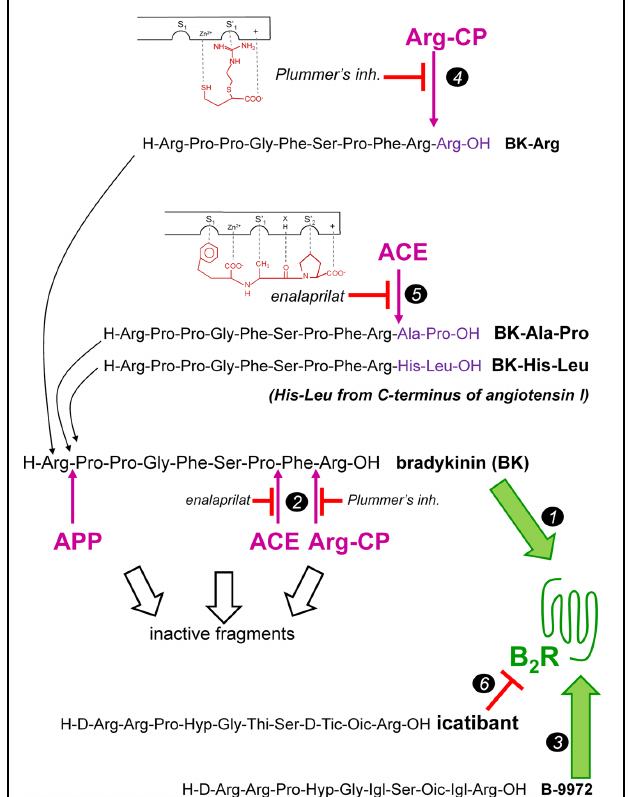
FIGURE 1 | Previously described BK-related peptides tested in vivo as B 2 R agonists in the present study. BK is a direct high affinity agonist (marker 1 ) that is intrinsically fragile, being degraded by several peptidases that terminate its signaling (some mentioned, marker 2 ). B-9972 is an inactivation-resistant agonist of the B 2 R by virtue of several of its non-natural residues (marker 3 ). Extended BK sequences as potential “prodrug” agonists of the B 2 R activated peptidases were also tested (markers 4 , 5 ). Icatibant, a peptide antagonist of the B 2 R, is a further direct ligand of the receptor (marker 6 ). The structure of peptidase-specific inhibitors exploited in the present study and their putative binding mode to the active sites of Arg-CP (Plummer’s inhibitor) or ACE (enalaprilat) are indicated (representation modified from Ondetti et al., 1977). Abbreviations: ACE, angiotensin converting enzyme; APP, aminopeptidase P; Arg-CP, arginine